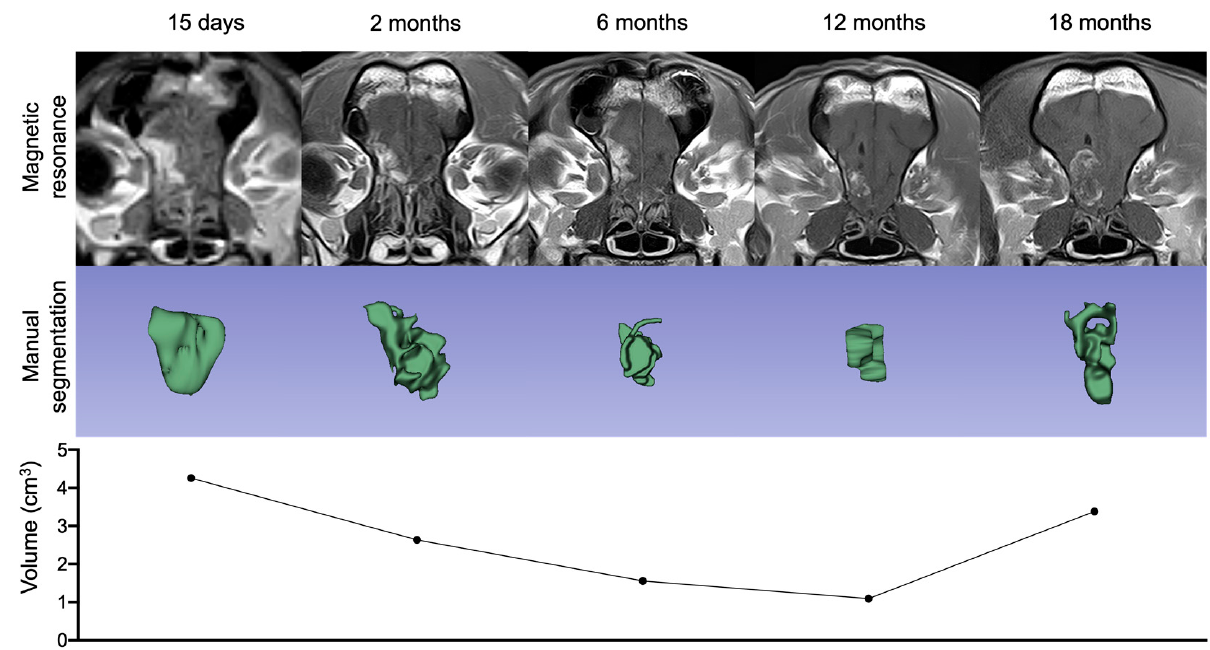
Figure 3. Magnetic resonance follow-up and volumetric response assessment. Representation of the T1-weighted postcontrast transverse sequence, the tumor imaged manual segmentations and volu- metric measurements during follow-up.